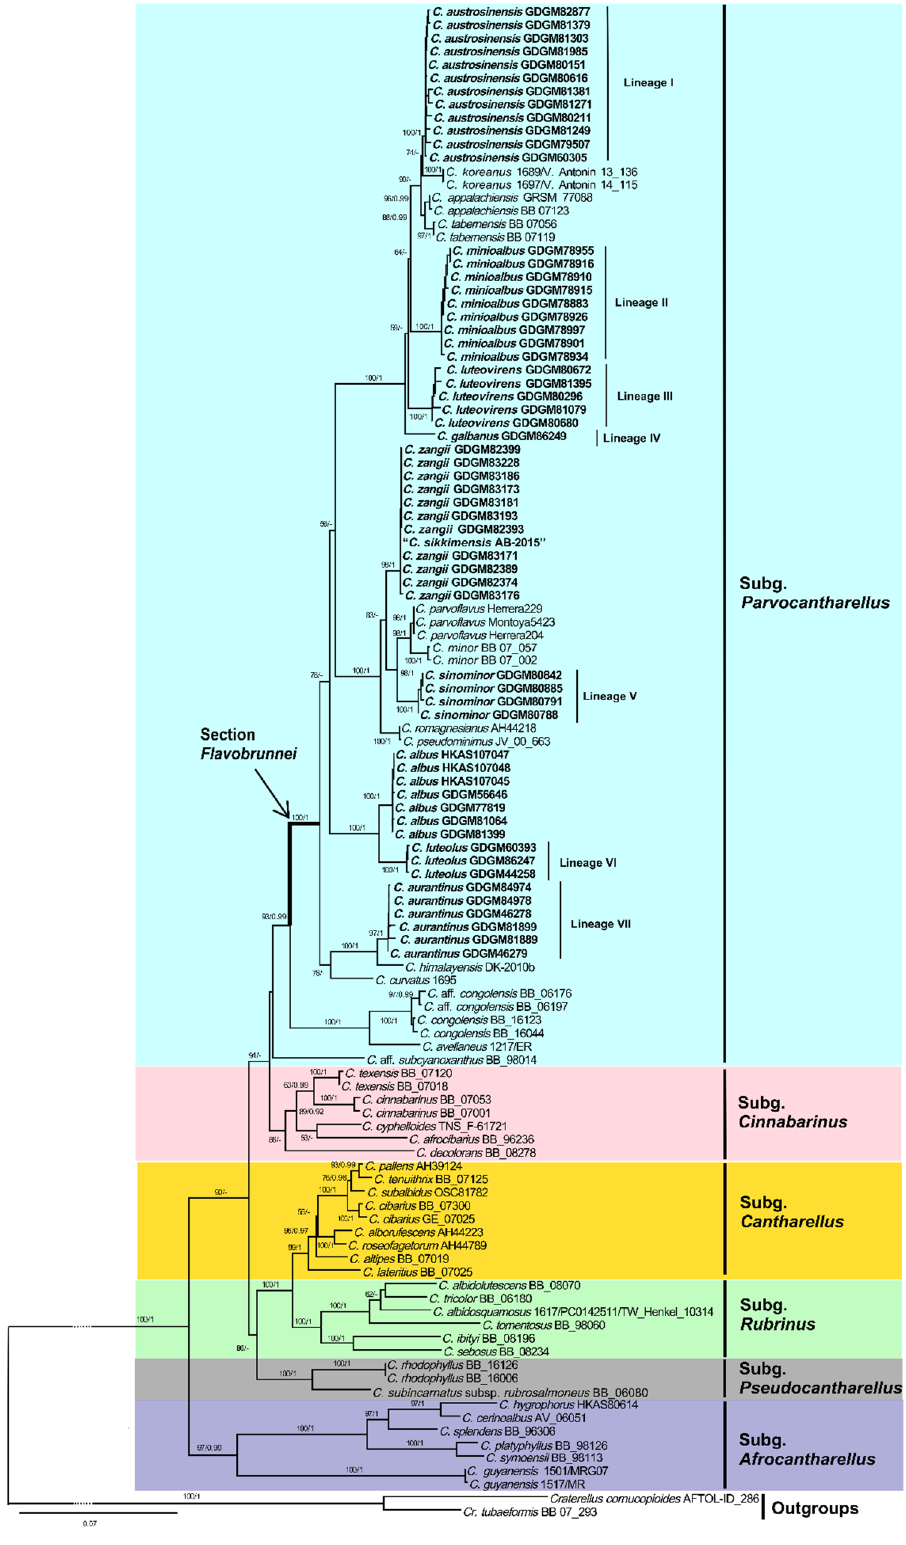
Figure 1. The phylogenetic tree of the representative species of Cantharellus that was inferred from a multigene (LSU + tef 1 + rpb 2) dataset by means of both ML and BI methods. Craterellus cornucopioides BB 07_293 and Cr. tubaeformis AFTOL ID_286 were used as outgroups. The maximum likelihood tree is depicted. The bootstrap supports (BS ≥ 50%) and Bayesian posterior probabilities (BPP ≥ 0.90) are shown on the supported branches. The species generated in this study are in black bold.